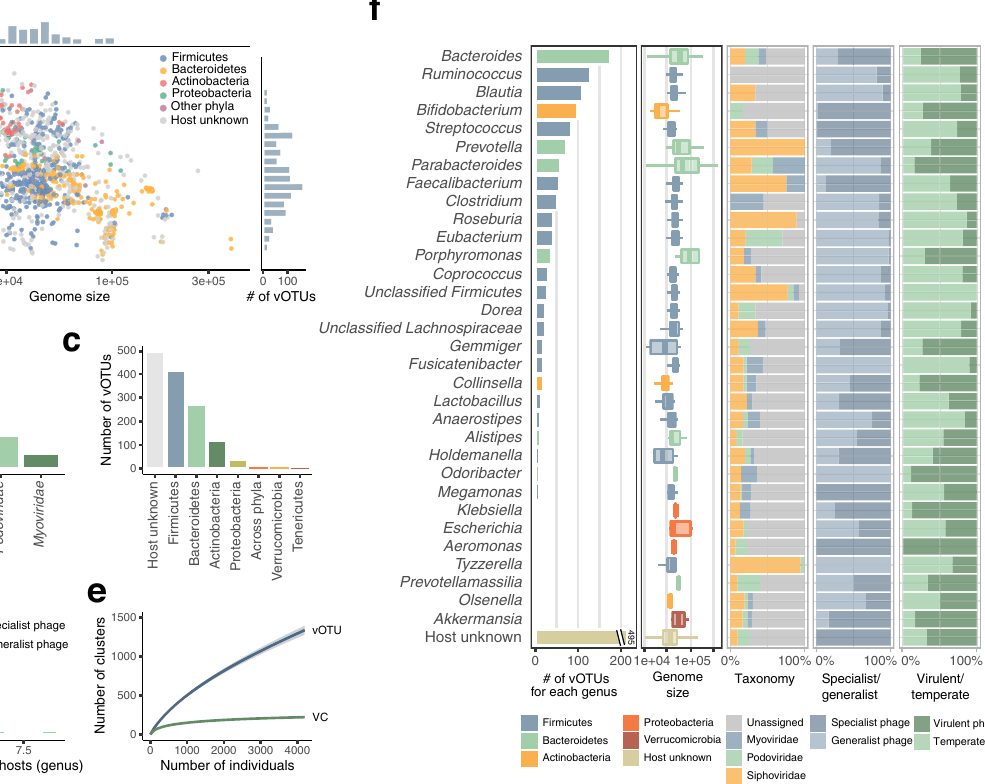
f Number of vOTUs, genome size, taxonomy, the ratio of specialist and generalist phages, and theratioofvirulentand temperatephagesforeachpredictedhost(at the genus level). If a vOTU was predicted to infect more than one genus, it was distributed to all the predicted genera. Thirty-three genera predicted to be infec- ted with more than 5 vOTUs are shown in the fi gure. In boxplots, boxes represent the interquartile range (IQR), and the lines inside show the median. Whiskers denote the lowest and highest values within 1.5 times the